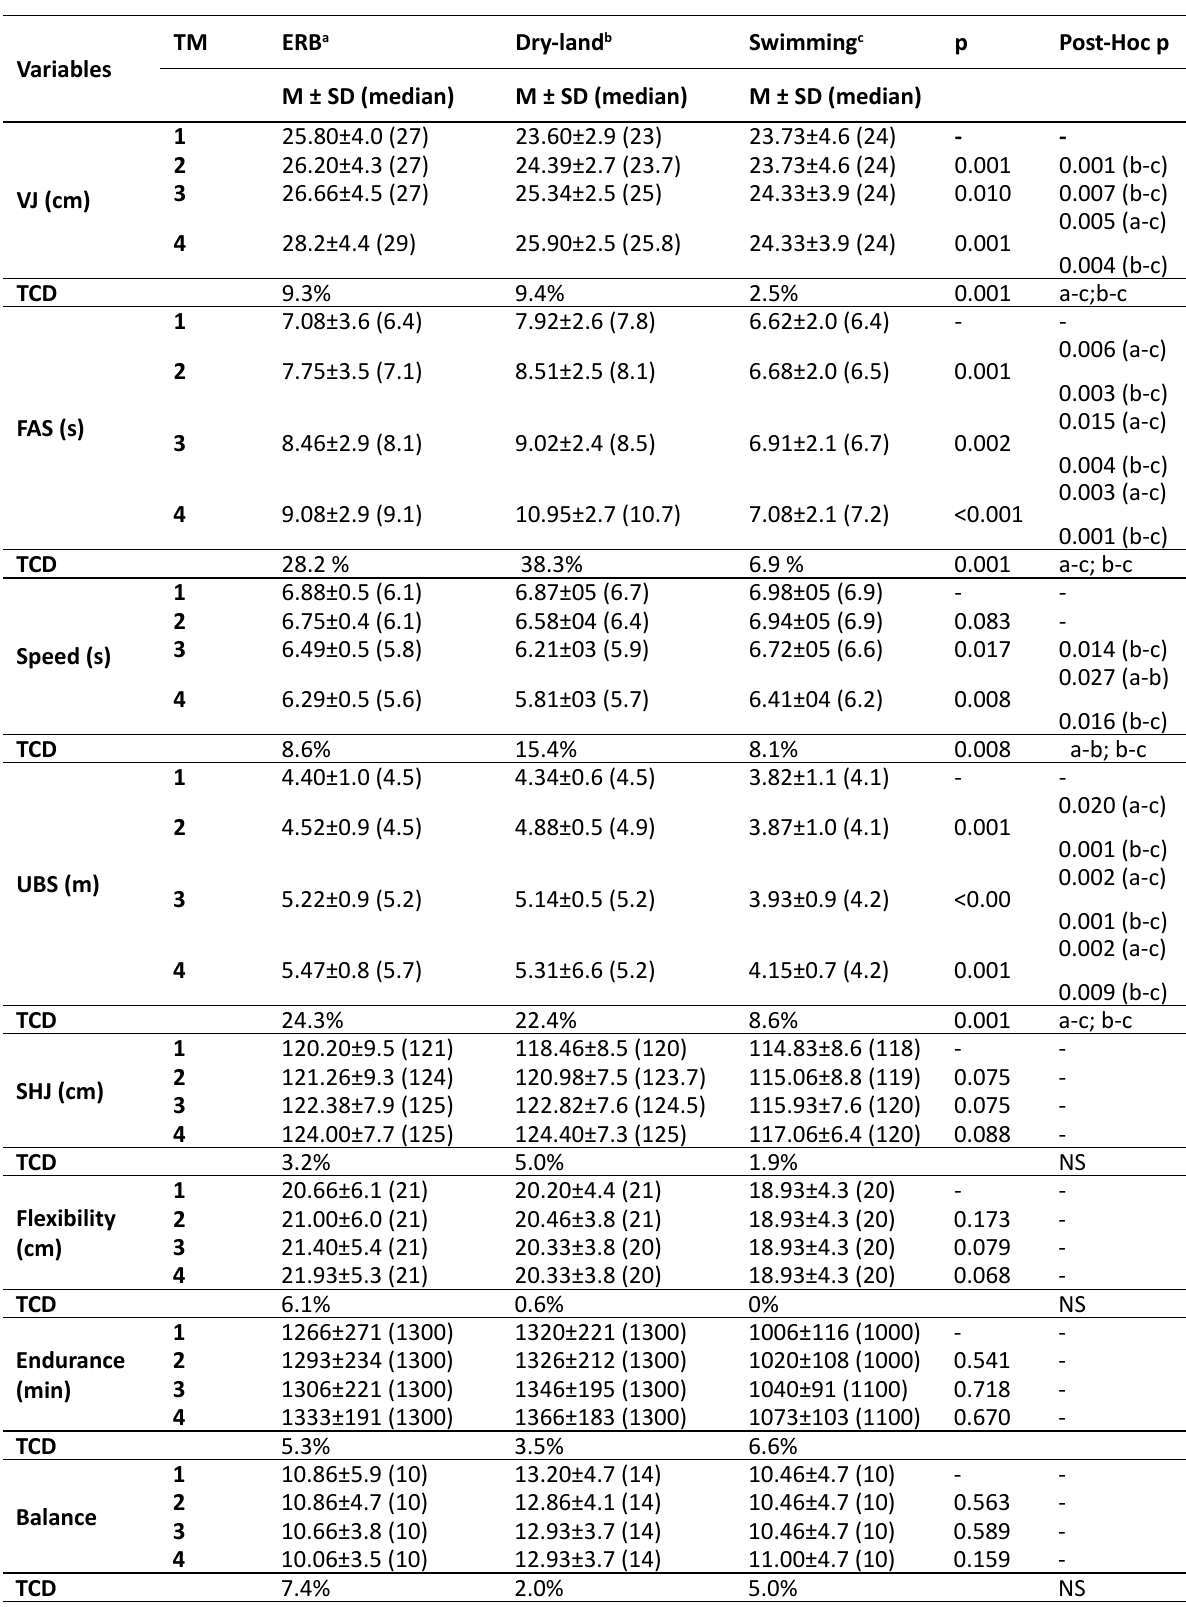
Table 3. The performance variables as based on the assessment times and total change difference.